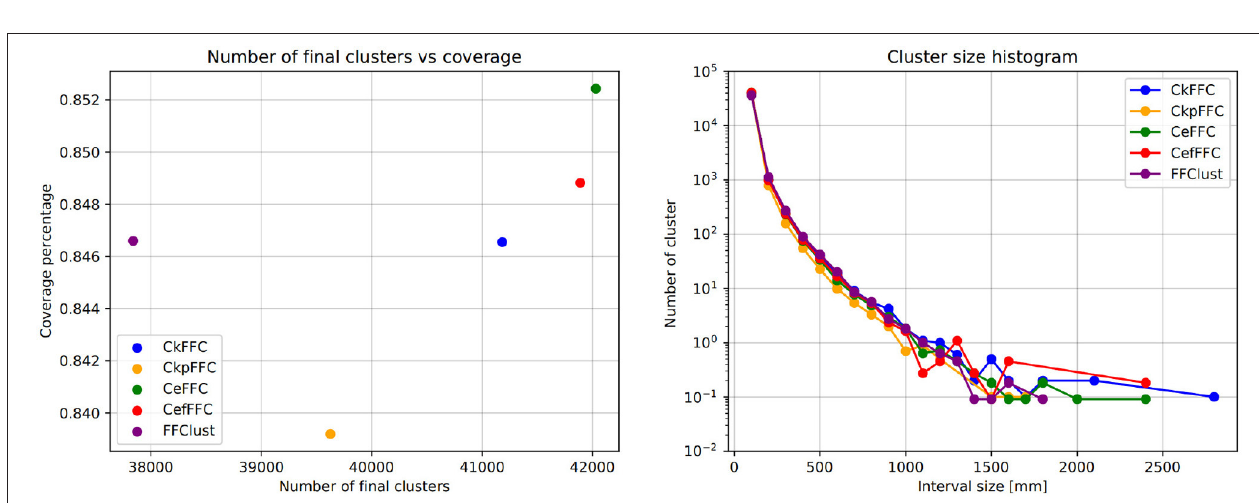
FIGURE 6 | Coverage and size histogram of final clusters. The CeFFC alternative obtains the highest number of clusters and coverage of fibers. It also contains a few bigger clusters than FFClust.